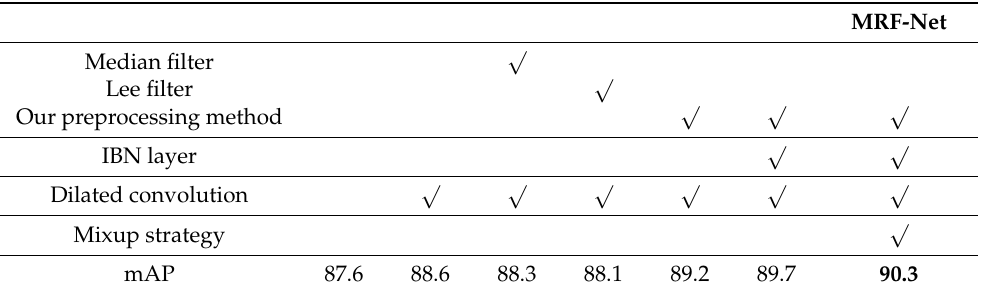
Table 5. Effectiveness of techniques in our proposed